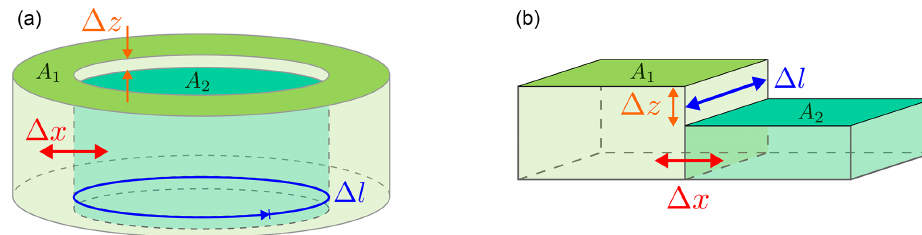
Figure 4. Geometries indicated by relationships between spatial model parameters for polygons (a) and palsa mires (b) .